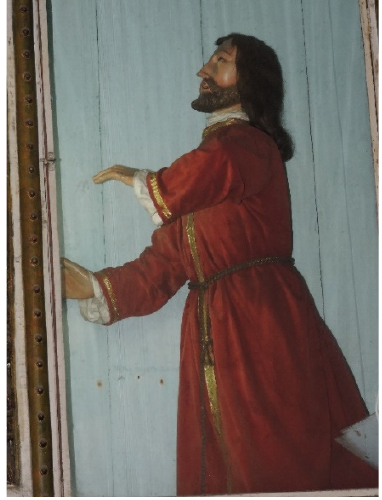
Figure 11. Agony in the Garden , in the Church of the Third Order of Mount Carmel in Santos. Polychrome wood sculpture (96 × 50 × 40 cm), eighteenth century. Photo by Lia Brusadin, 29 December 2016.